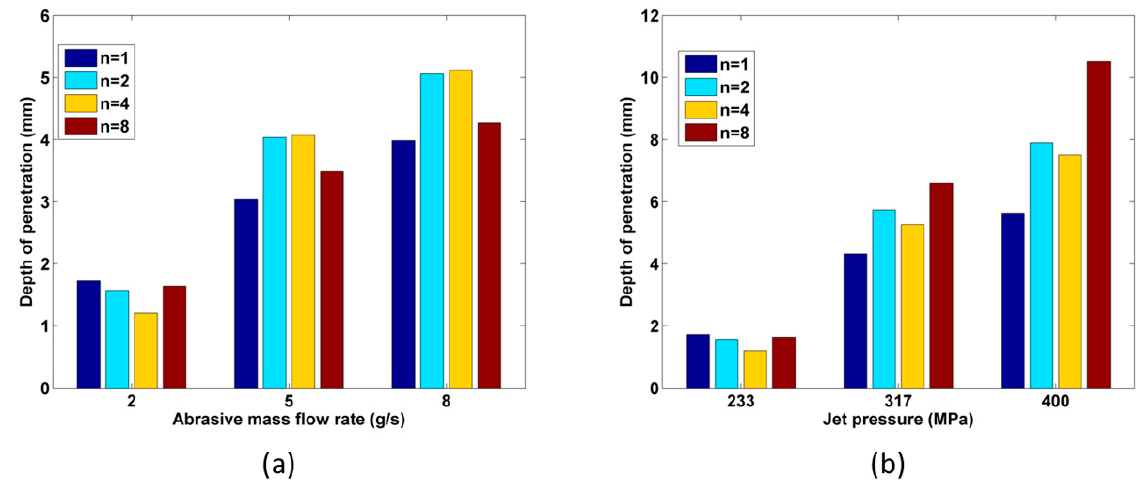
Figure 4. Variation of the depth of penetration for increasing number of passes in respect to ( a ) abrasive mass flow rate and ( b ) jet pressure.